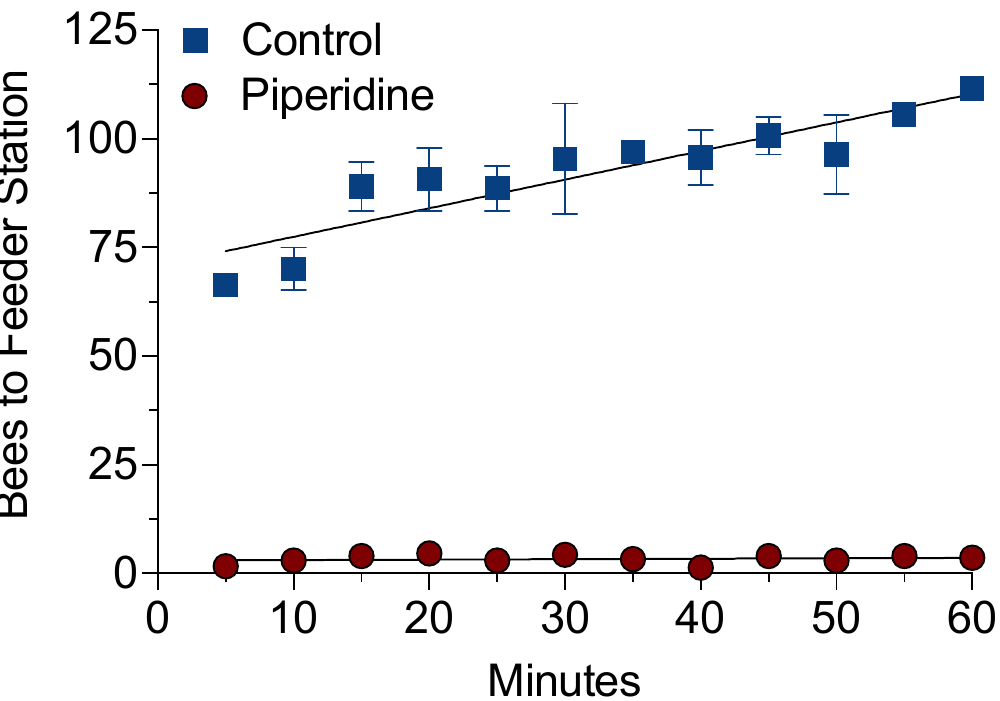
Figure 6. Number of honey bees visiting a feeder station treated with piperidine. Two high tunnels contained two nucleus bee colonies that were trained to a feeder station containing 50% ( w / v ) sucrose solution for 9 d. The sucrose solution was replaced at the feeder station with 10 µ L/mL piperidine in a sucrose solution on day 10. The number of bees visiting the piperidine-untreated (control) and -treated feeder stations was video recorded for 60 min. Data were analyzed using linear regression analysis. Symbols represent the mean ± standard error and when absent the error bars are within the size of the symbol. Control equation: Y = 0.6578*X + 70.85, R 2 = 0.53. Treatment equation: Y = 0.01026*X + 3, R 2 = 0.005.